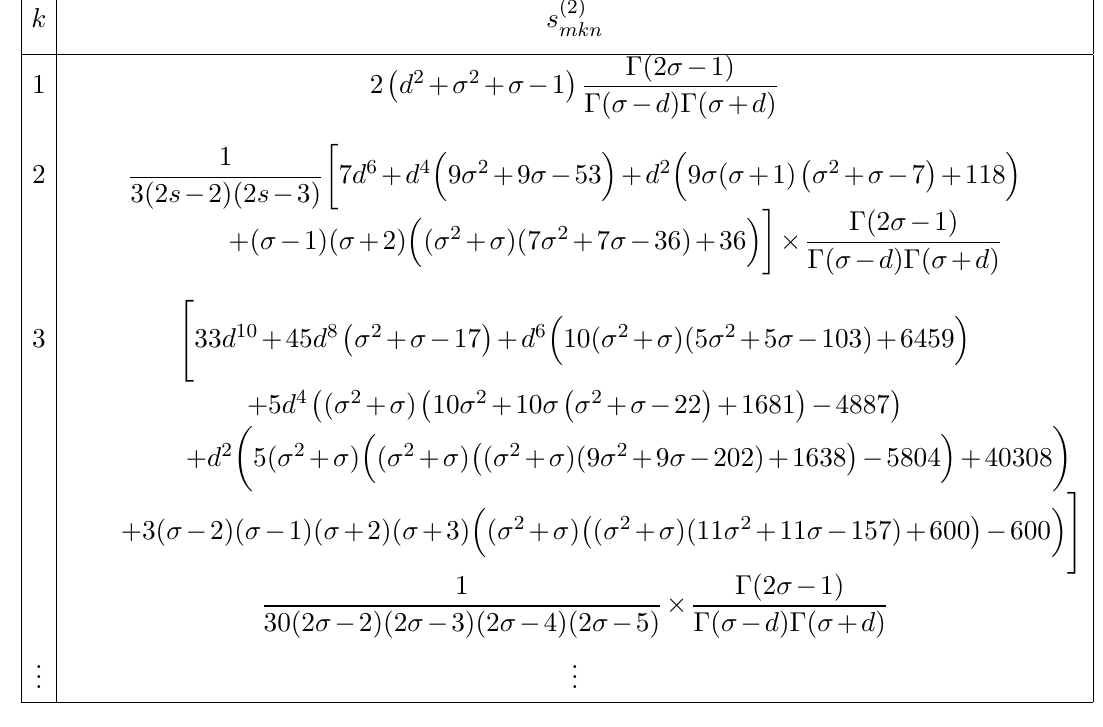
Table 1 . Table of s (2) evaluated for some small values of k mkn